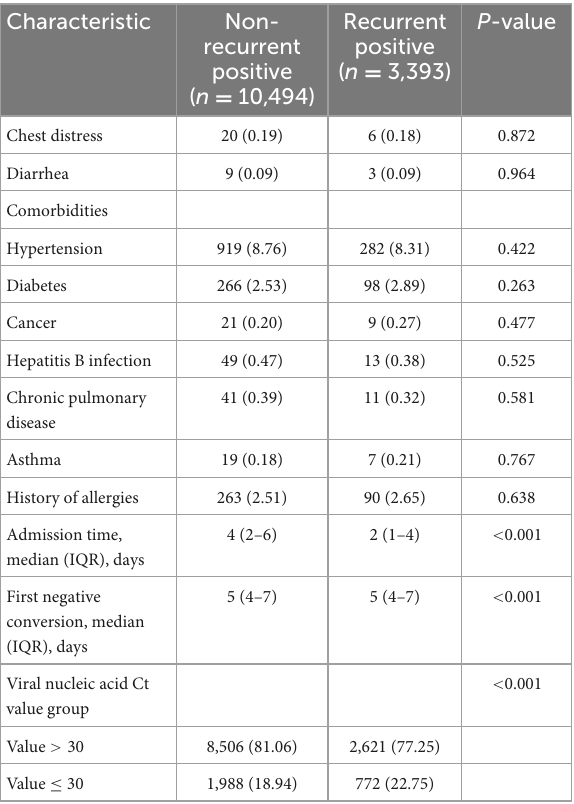
TABLE 2 Demographics and characteristics of patients infected with SARS-CoV-2 in the training